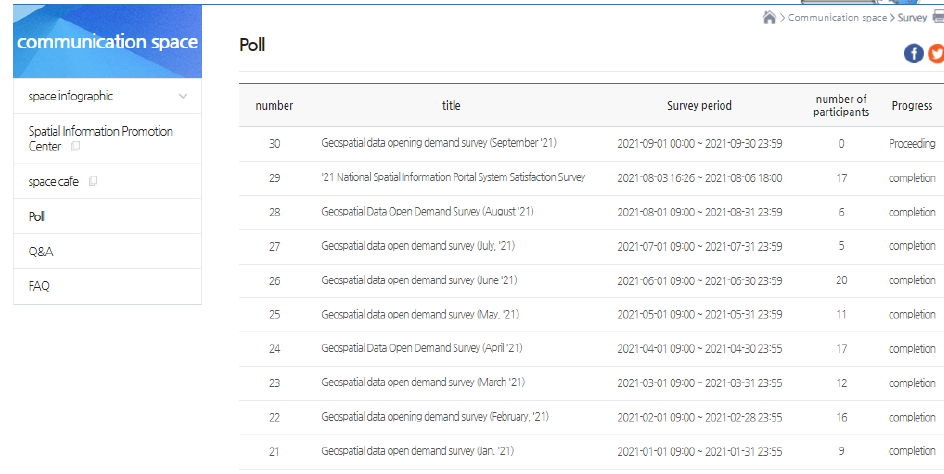
Figure 10. User opinion recruitment on ‘poll’.